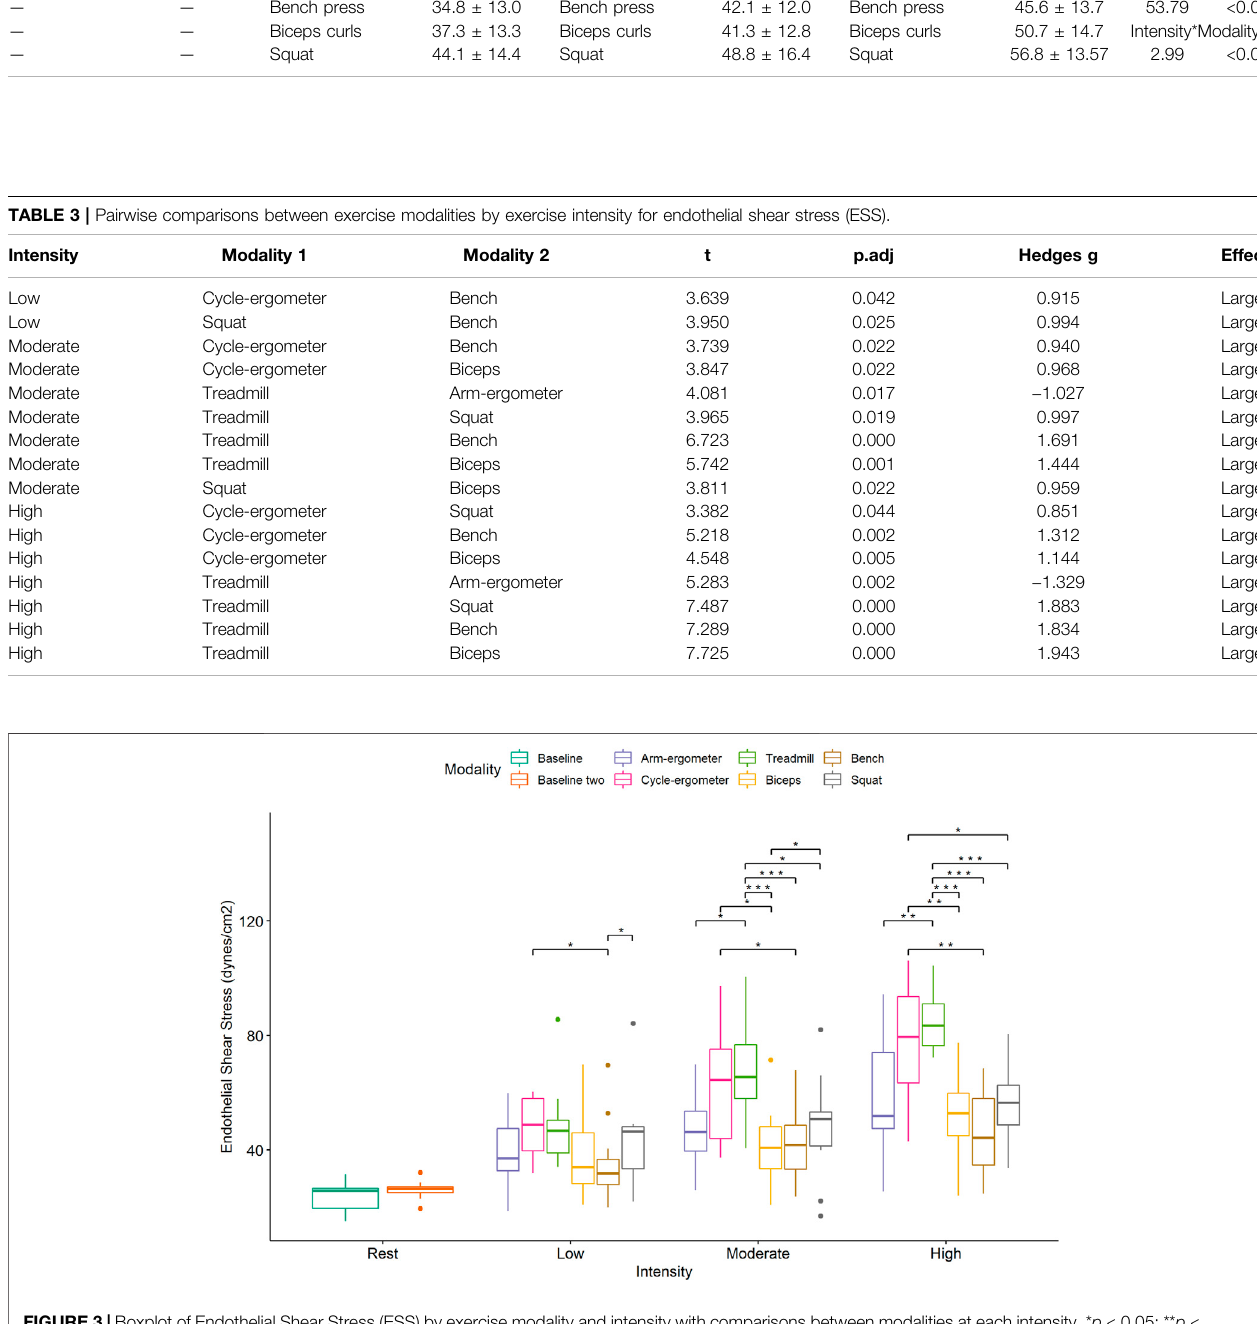
FIGURE 3 | Boxplot of Endothelial Shear Stress (ESS) by exercise modality and intensity with comparisons between modalities at each intensity. * p < 0.05; ** p < 0.01; ***, p < 0.001.